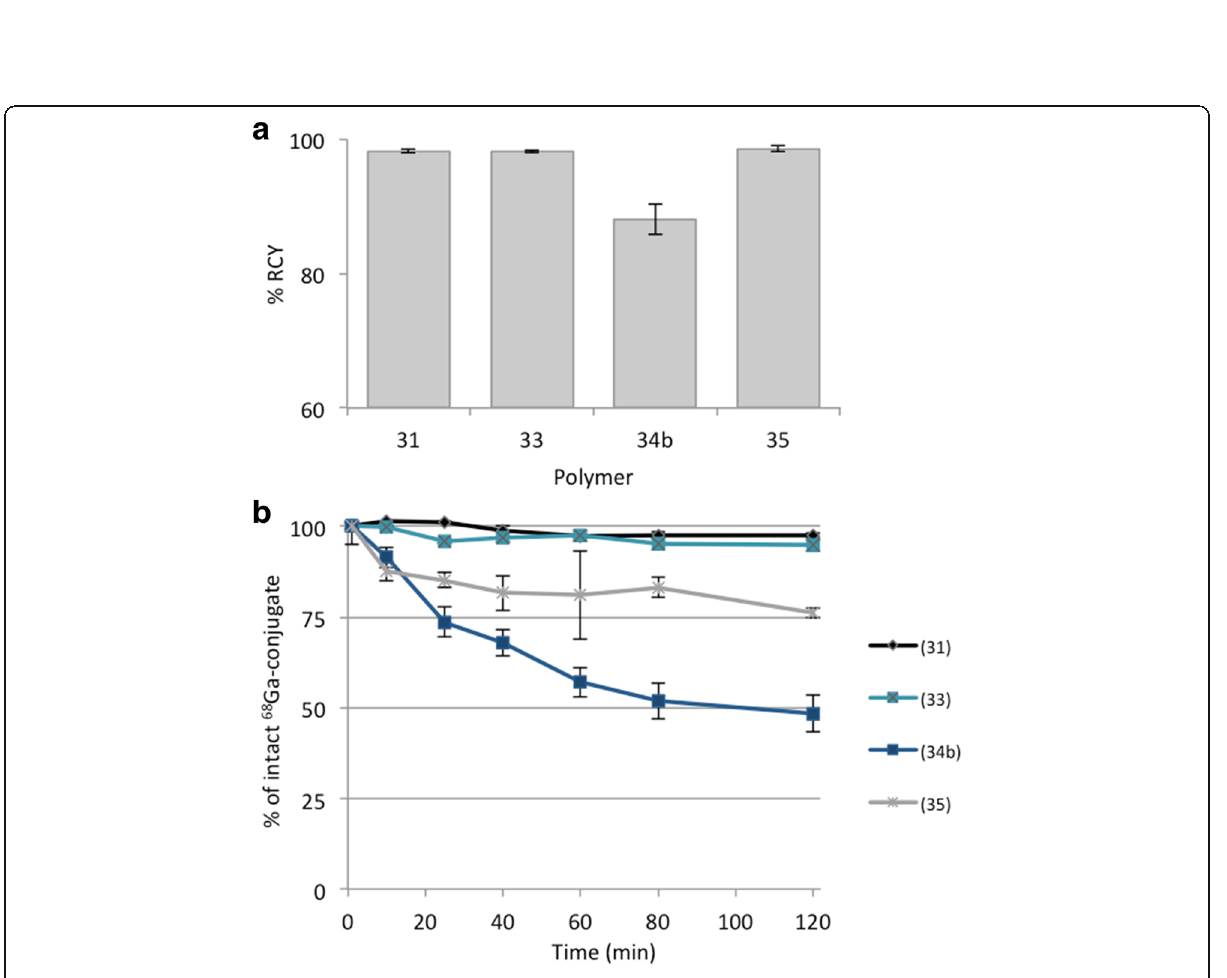
Fig. 7 Stability of gallium-68-labeled conjugates in 0.9% NaCl ( a ) and in HSA ( b ) within 120 min at 37 °C ( n =